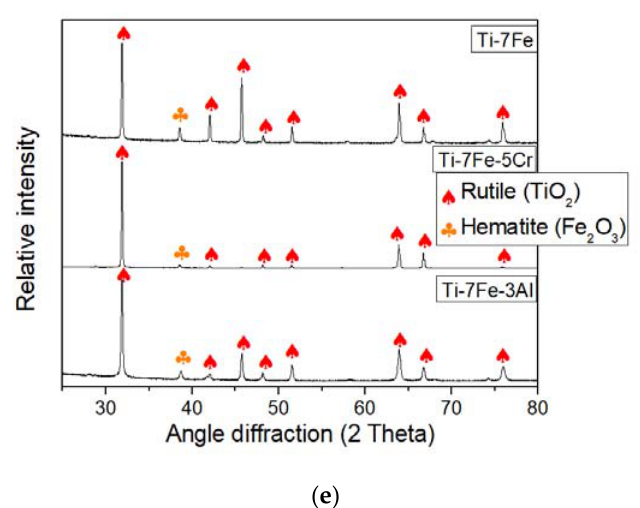
Figure 7. Backscattered electron image of cross section of ( a ) Ti ‐ 7Fe ‐ 5Cr, ( b )Ti ‐ 7Fe, ( c )Ti ‐ 7Fe ‐ 3Al, ( d ) unalloyed Ti, and ( e ) XRD patterns of samples tested at 600 °C for 300 h.